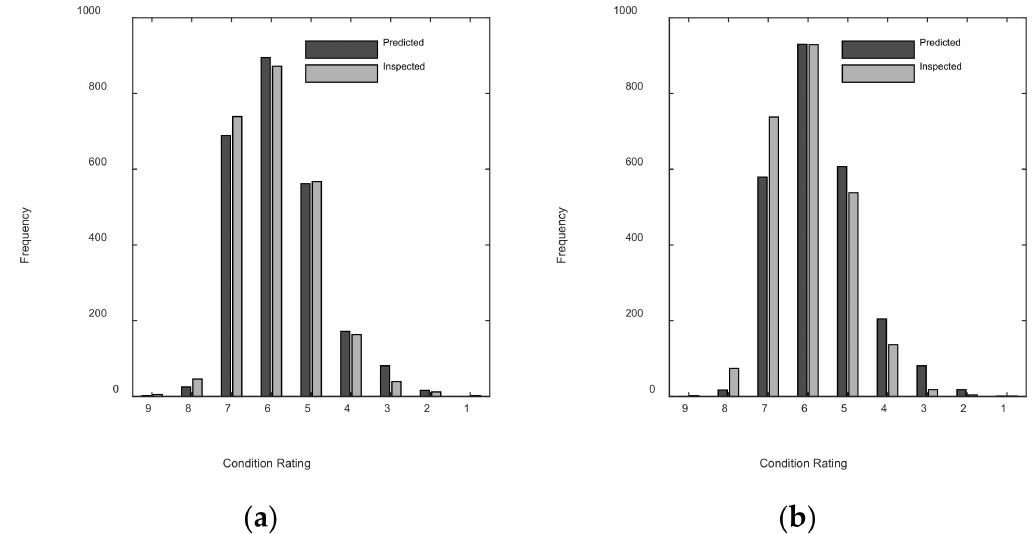
Figure 14. Bridge distribution comparison between inspection and predicted condition ratings without considering classification for ( a ) two-year and ( b ) four-year prediction.